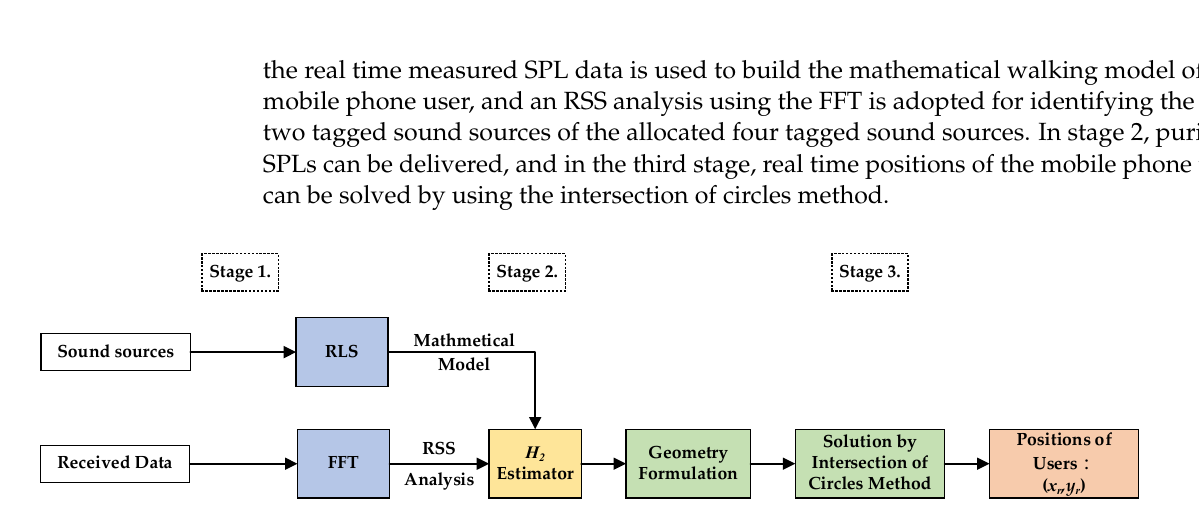
Figure 11. The flow chart of the proposed indoor positioning algorithm for practical tests.